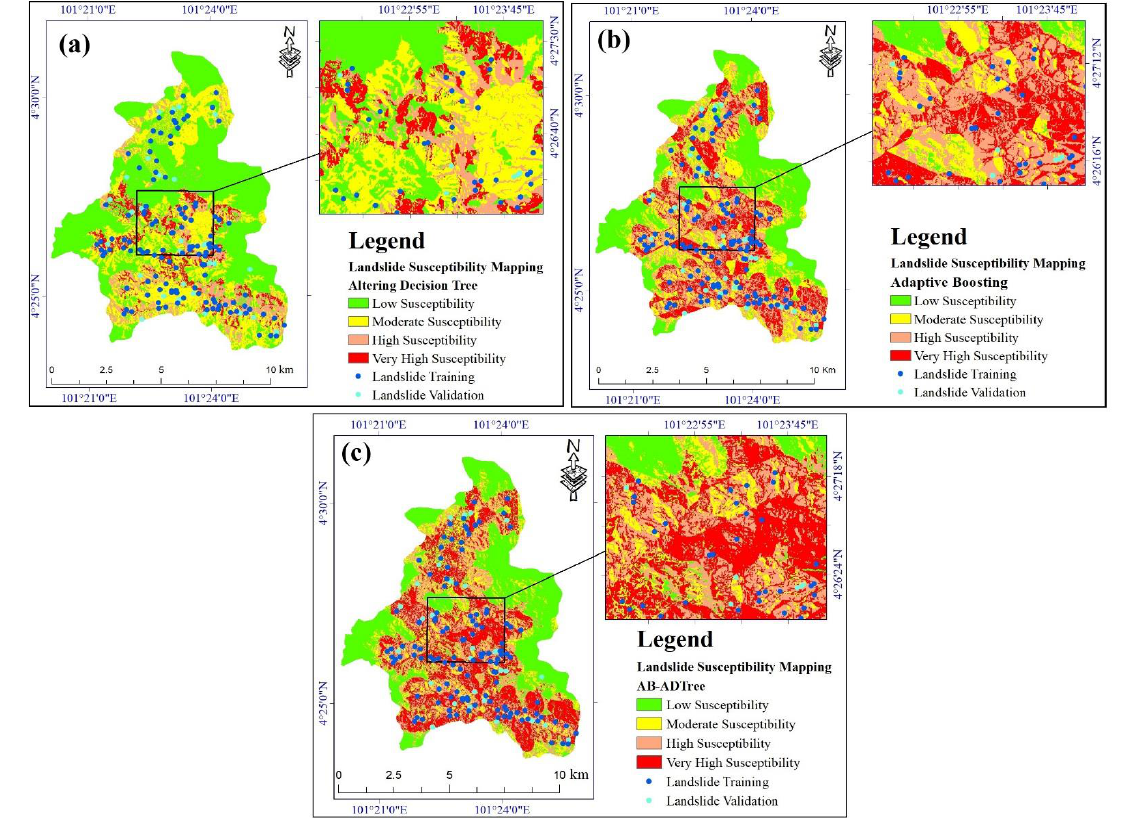
Figure 11. Landslide susceptibility maps: ( a ) ADTree; ( b ) AB; and ( c ) AB-ADTree.